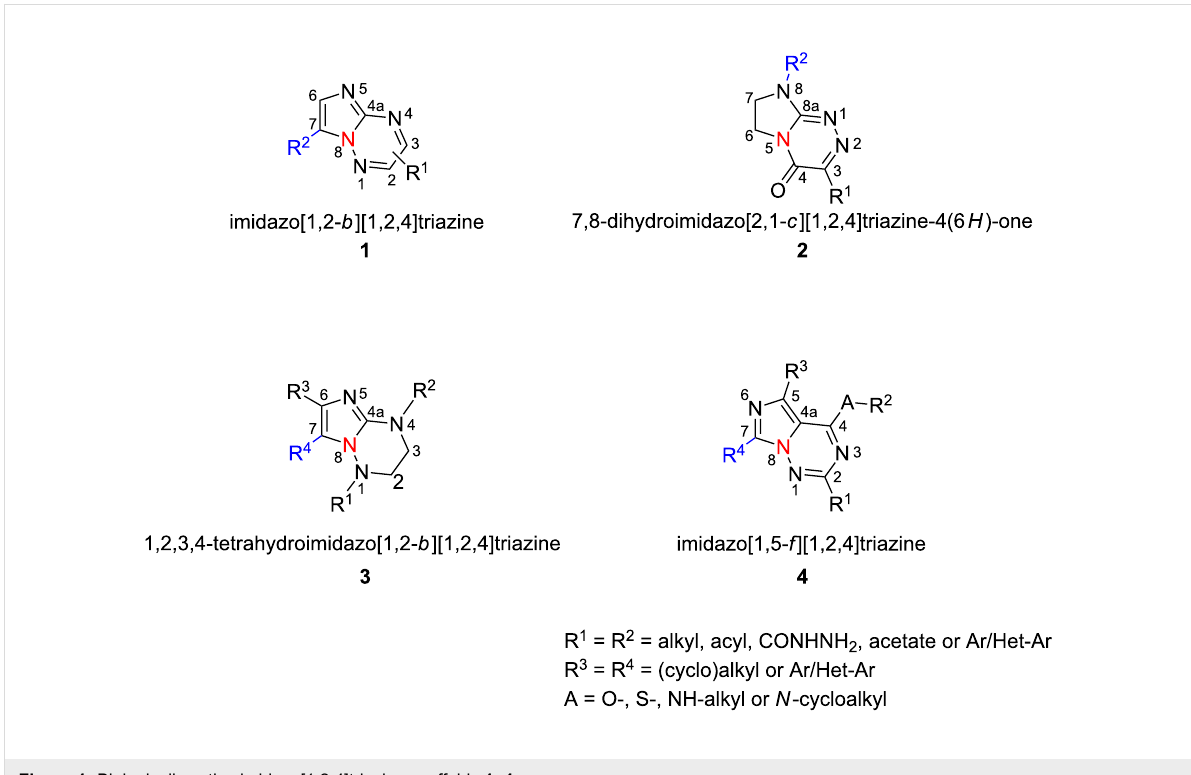
Figure 1: Biologically active imidazo[1,2,4]triazine scaffolds 1 – 4